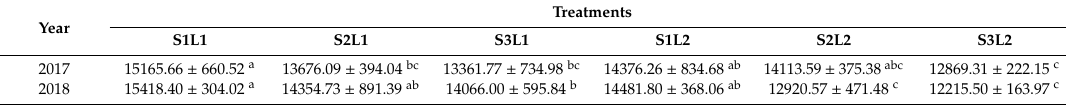
Table 4. Maize yield under di ff erent treatments [kg · hm − 2 ]